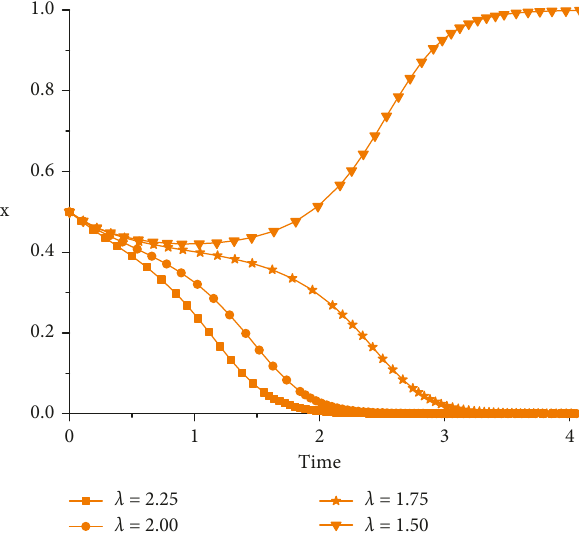
Figure 14: Impact of risk preference coefficient on enterprise 1.